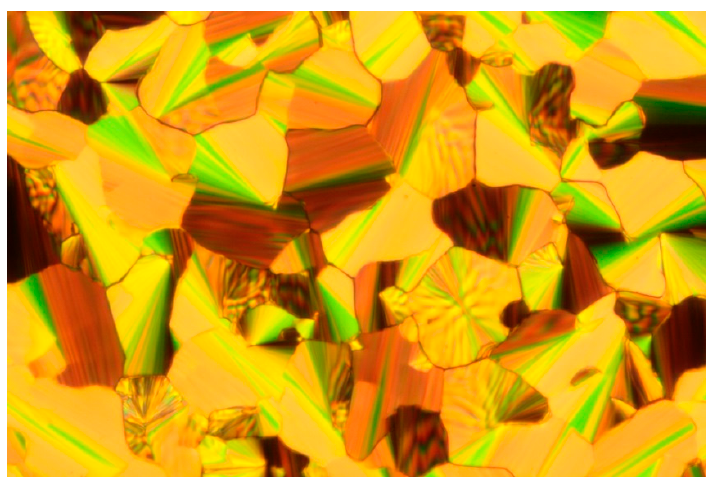
Figure 2. Differential scanning calorimetry (DSC) thermographs for compounds ( a ) 8BVJH12 and ( b ) LJ10/10 . The second heating is presented in red color and the second cooling in blue color. Phases are indicated.